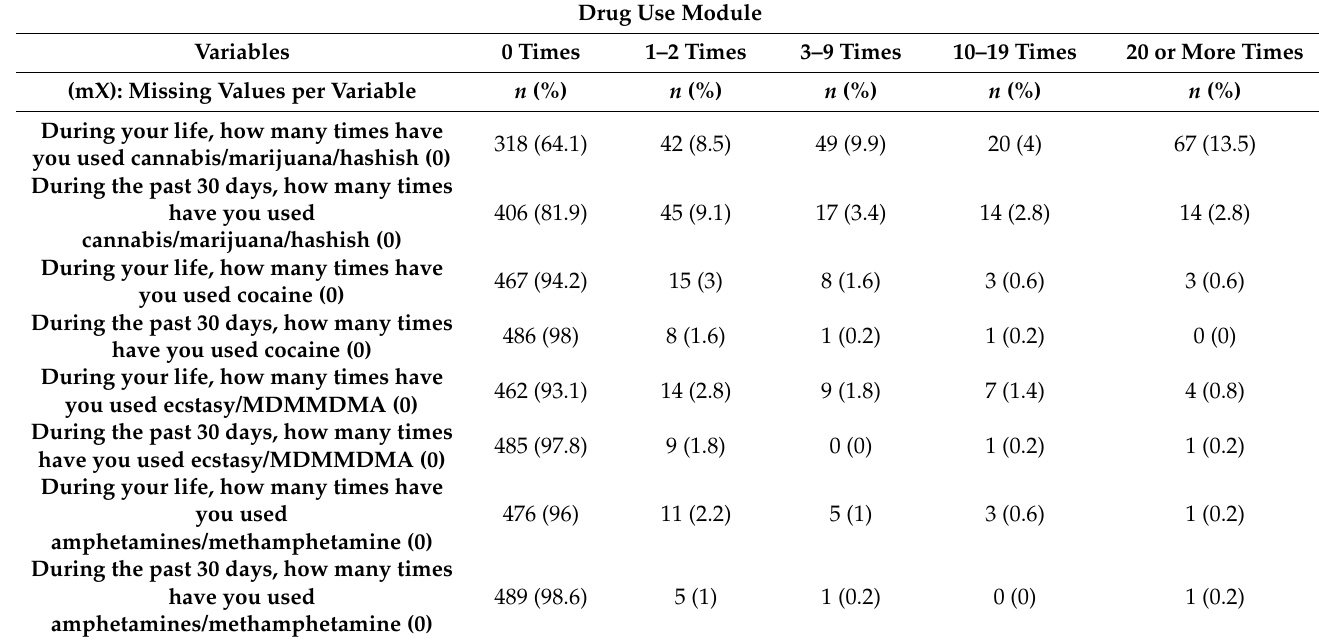
Table 3. Illicit drugs use module based on Global School-Based Student Health Survey. Drug Use Module